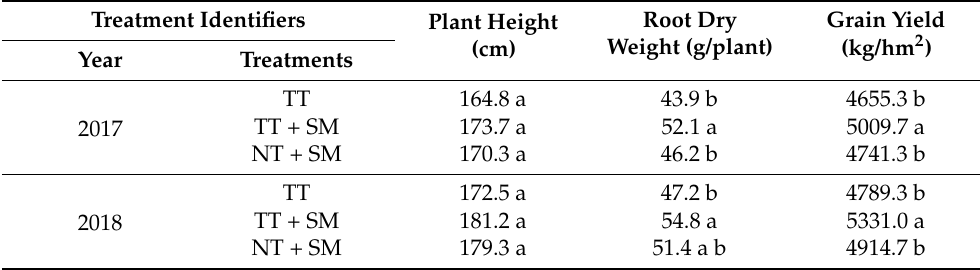
Table 4. Plant height and root dry weight at maturity stage, as well as the final grain yield for maize cultivation under the traditional tillage without straw return (TT), traditional tillage with straw mulching (TT + SM), and no-till cultivation combined with straw mulching (NT + SM) treat- ments. Mean values within a column in the same year followed by a different letter are significantly different ( p =